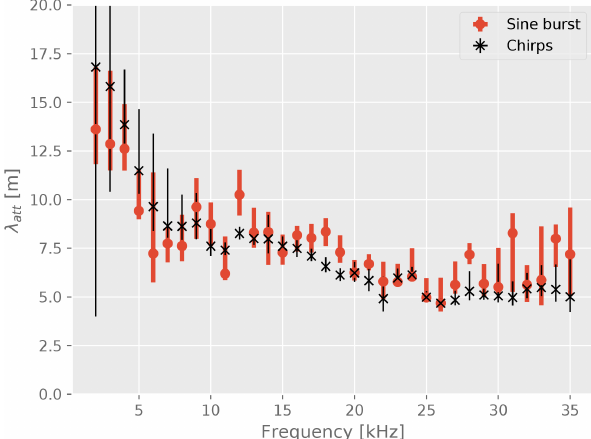
Figure 14. Attenuation lengths for all frequencies. Shown are the results based on sine bursts (red bullets) as well as chirps (black